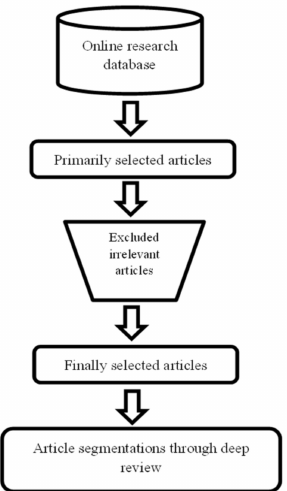
Figure 1. The literature review